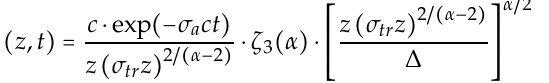
( n = 0 ) α as a function of index α